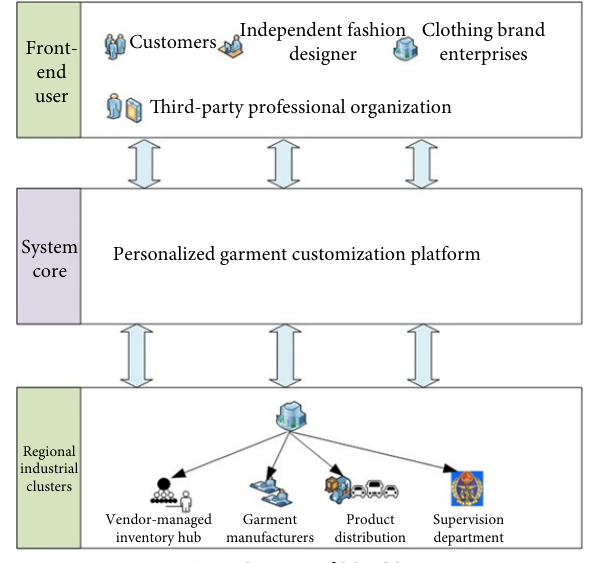
Fig. 1 Structure of